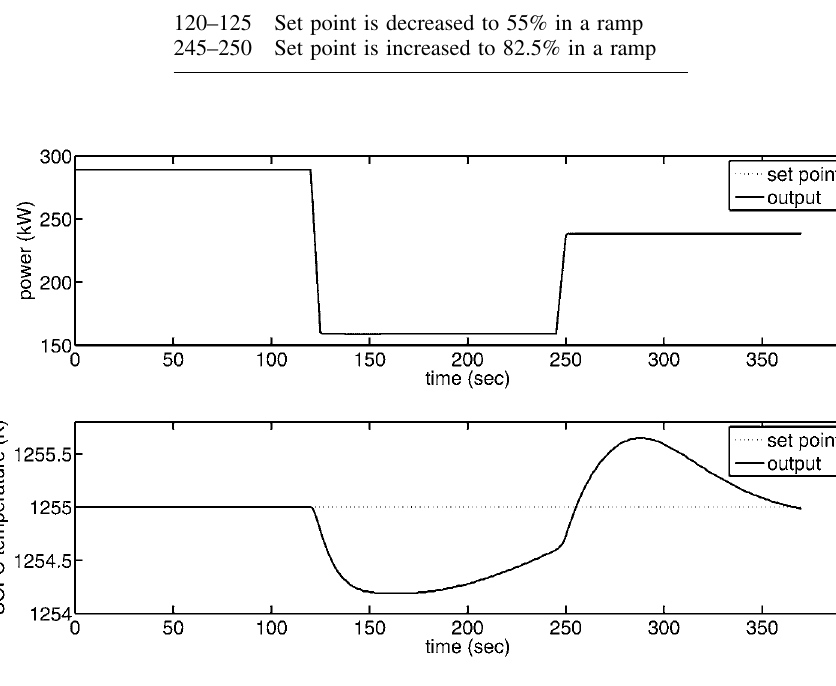
Figure 5. Output power and SOFC temperature during power set point changes.